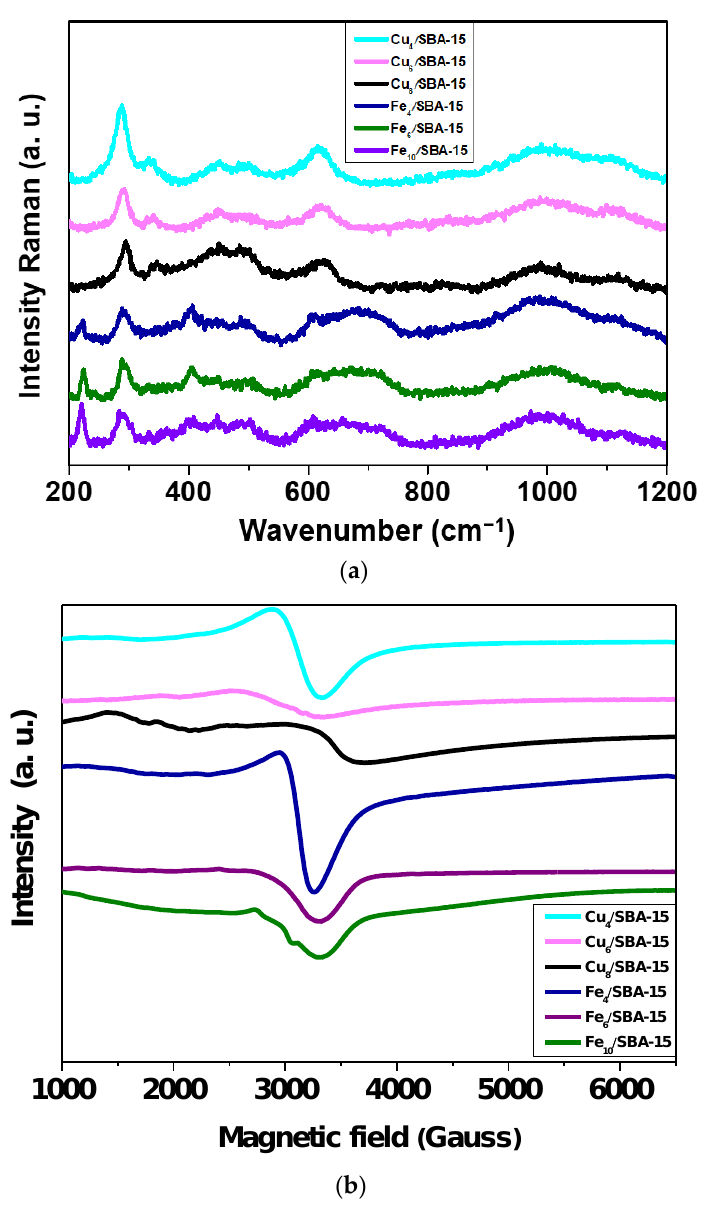
Figure 1. ( a ) Raman spectra of selected samples obtained in the range of 200 – 1200 cm −1 and ( b ) EPR spectra of selected samples taken at room temperature.